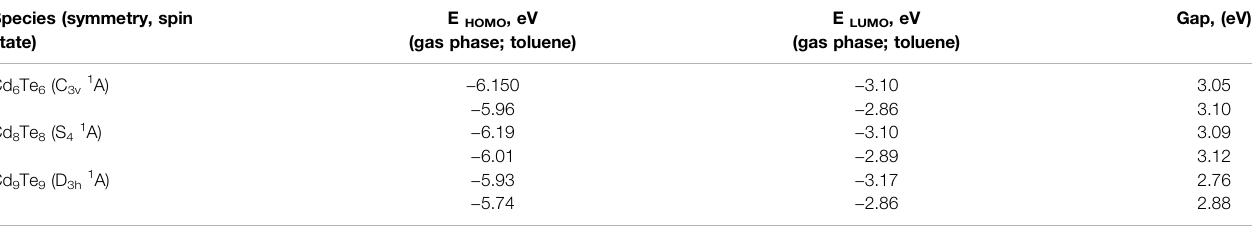
TABLE 1 | Calculated E HOMO and E LUMO energies (eV), HOMO-LUMO gaps (eV) of bare Cd n Te n ( n (cid:1) 6, 8, and 9) QDs in the gas phase, and toluene with B3LYP/Lanl2dz approach. Species (symmetry, spin state)